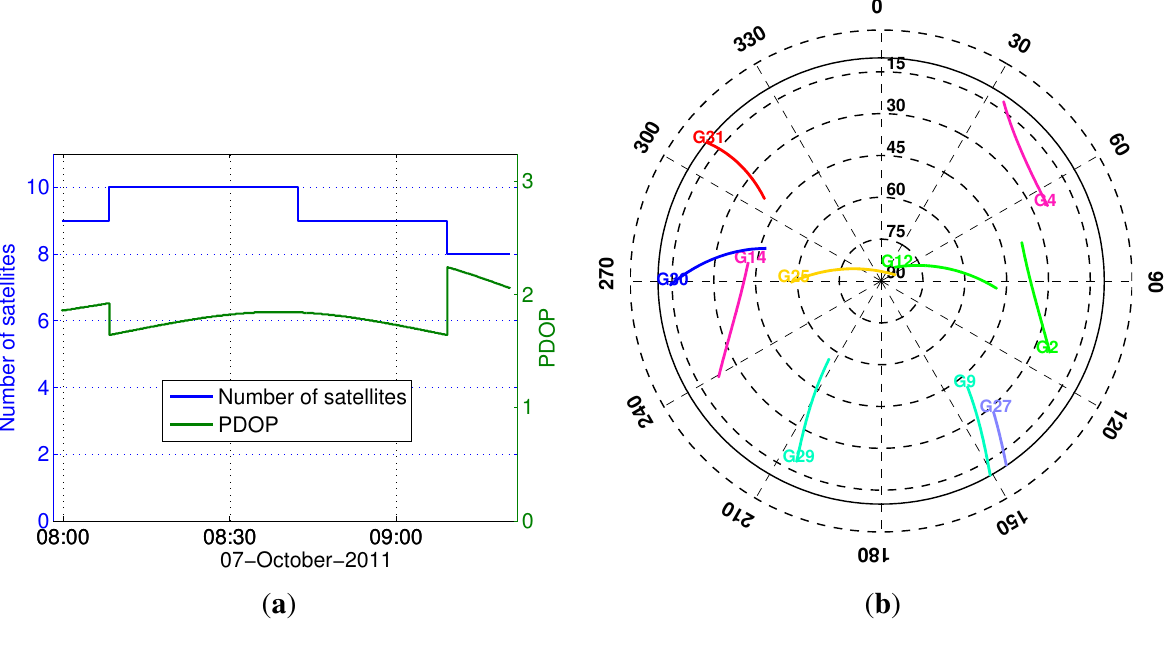
Table 6. Heading root mean square (RMSE) (deg) for kinematic data (0.6-m